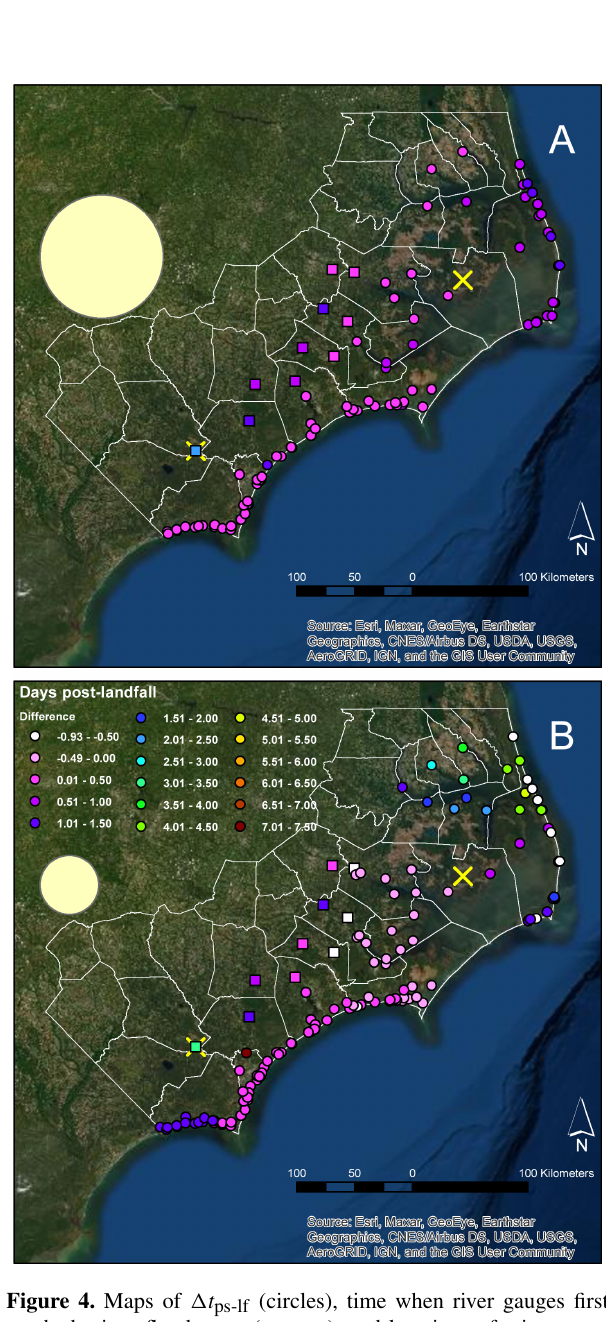
Figure 4. Maps of (cid:49)t ps-lf (circles), time when river gauges first reached minor flood stage (squares), and locations of rain gauges (crosses). Large circles represent the area of similarity in (cid:49)t ps-lf computed using the semivariogram range ( a ) as the radius. Panel (a) is for Matthew and (b) is for